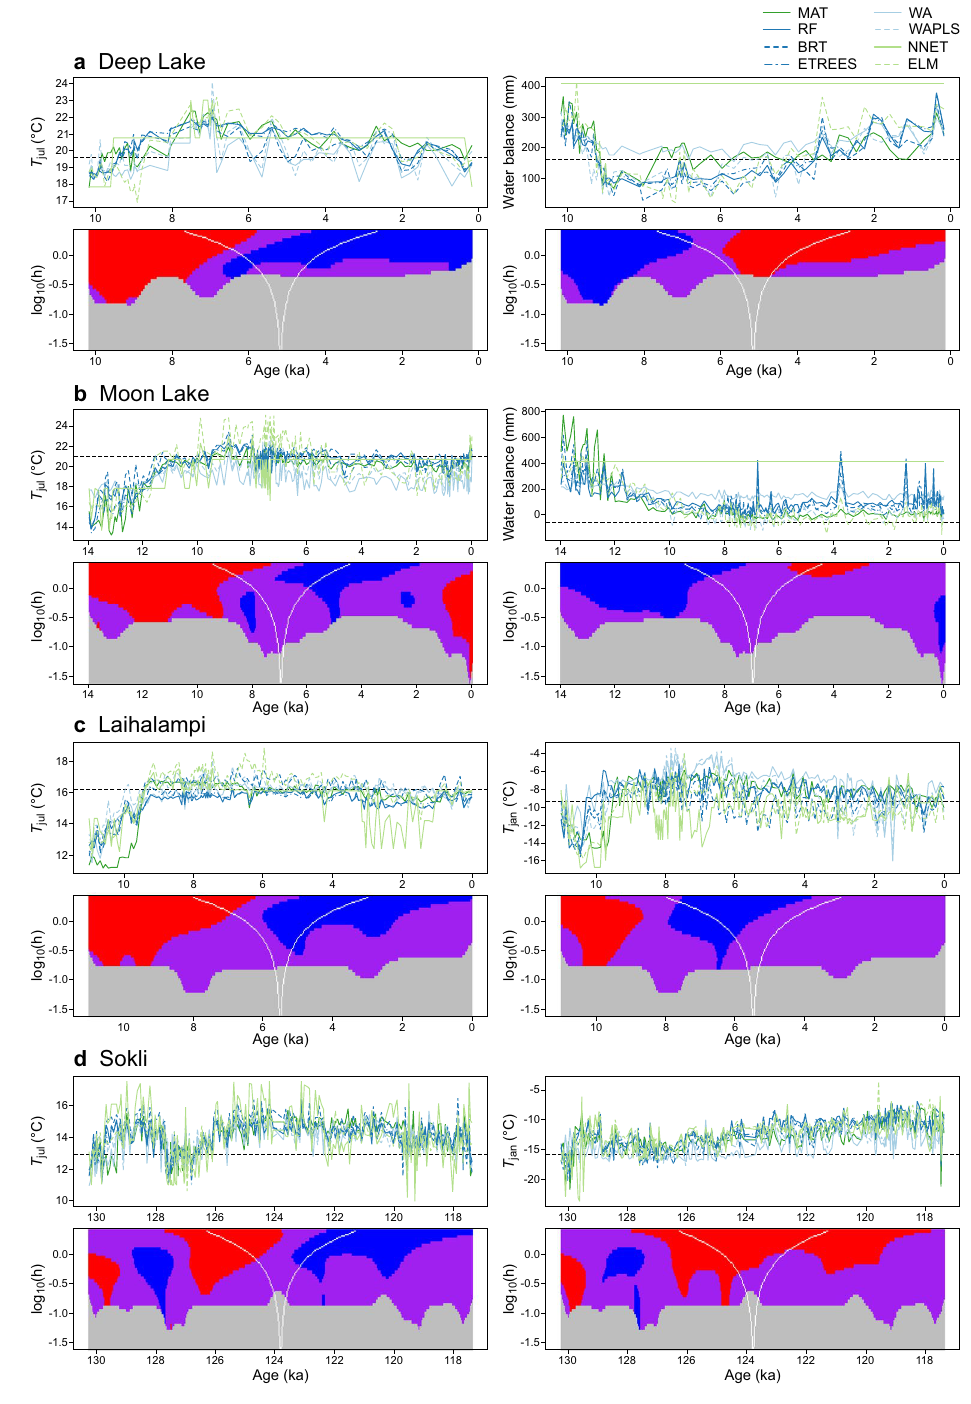
Figure 4. Palaeoclimate reconstructions. Reconstructions are shown for primary and secondary climate variables and prepared with eight calibration methods from each fossil dataset. The black dashed lines indicate the modern climate values at the fossil sites. The SiZer maps (lower panels) show the significant features of the reconstructions, based on the curve using the calibration method with the strongest CV performance for the climate variable in question (BRT or ETREES; Table 3). The reconstruction is smoothed at different bandwidths, with the bandwidth used at each point on the vertical axis indicated by the horizontal distance between the white lines. For each point in time and each bandwidth ( h ), red indicates a significant rising trend, blue a significant falling trend, purple a lack of a significant trend, and grey a lack of sufficient data for meaningful